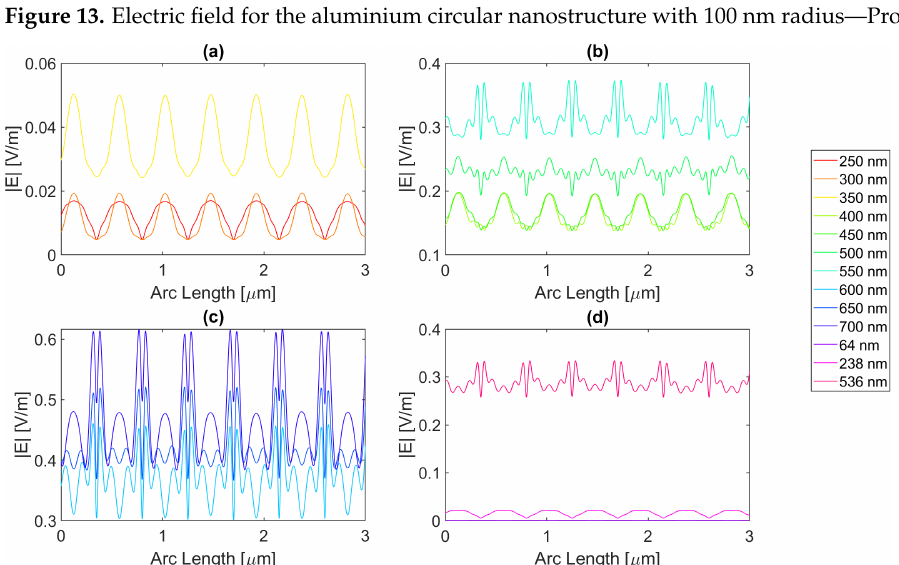
Figure 14. Electric field for the gold circular nanostructure with a 100 nm radius—Probe